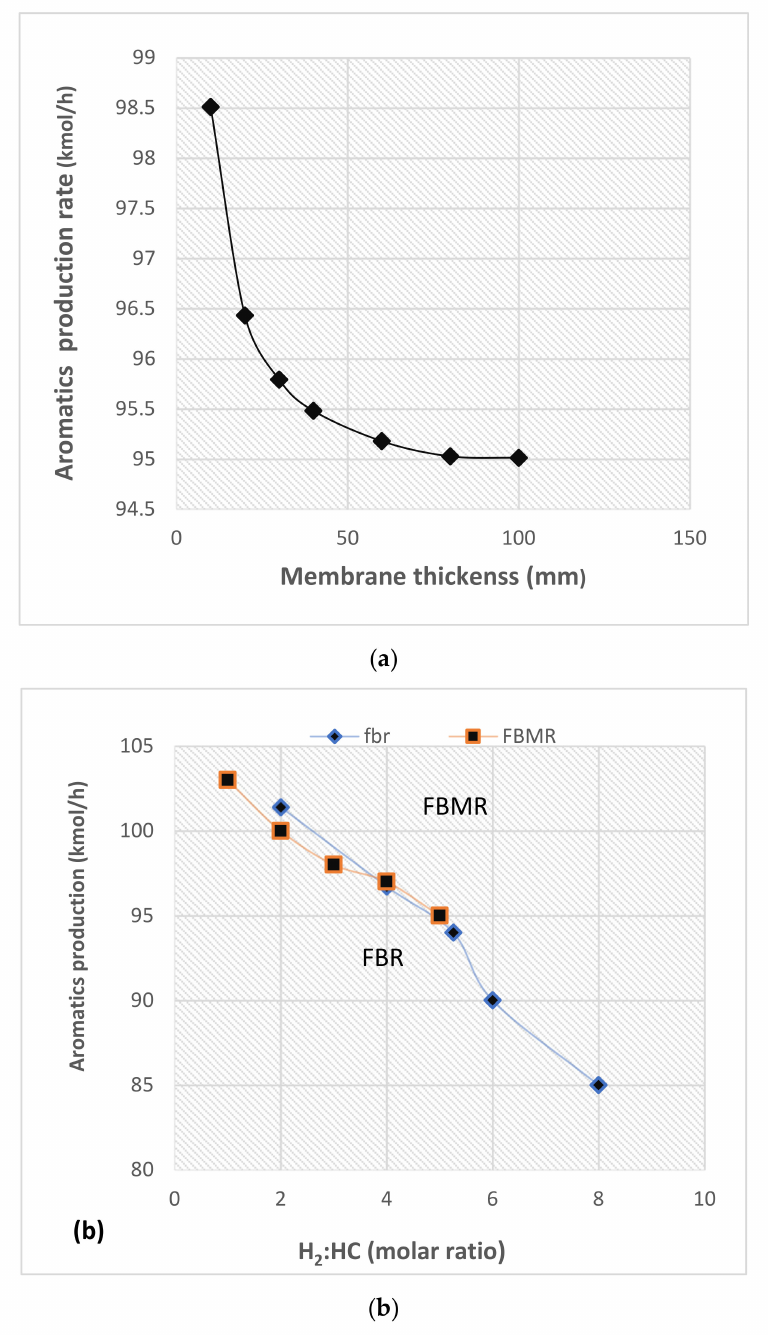
Figure 10. ( a ) Aromatic production as a function of the membrane; ( b ) aromatic production rate vs. H 2 /HC ratio.4.2.4. Influence of H 2